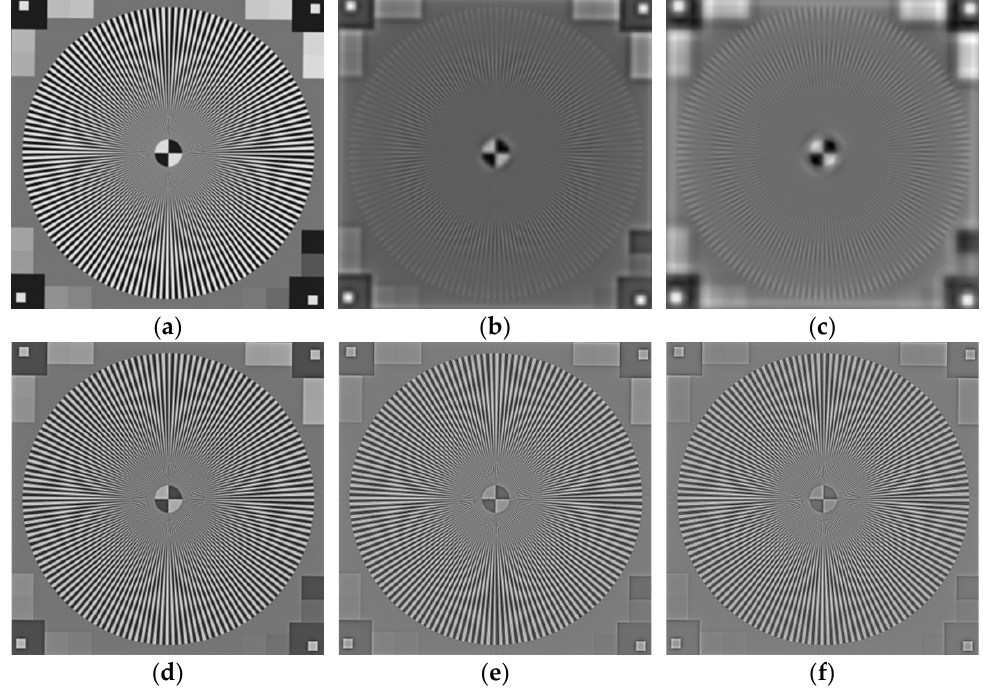
Figure 5. Digital resolution chart images reconstructed by basic filters with different parameters: ( a )